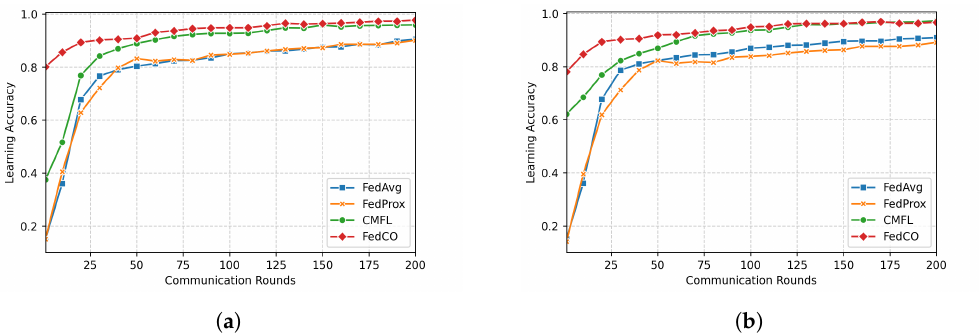
Figure 5. Learning accuracy versus the number of communication rounds for MNIST data. The top plot presents the results produced in the case of the IID data distribution scenario, while the bottom plot depicts the results generated in the case of the Non-IID data distribution scenario. ( a ) IID; ( b ) Non-IID.